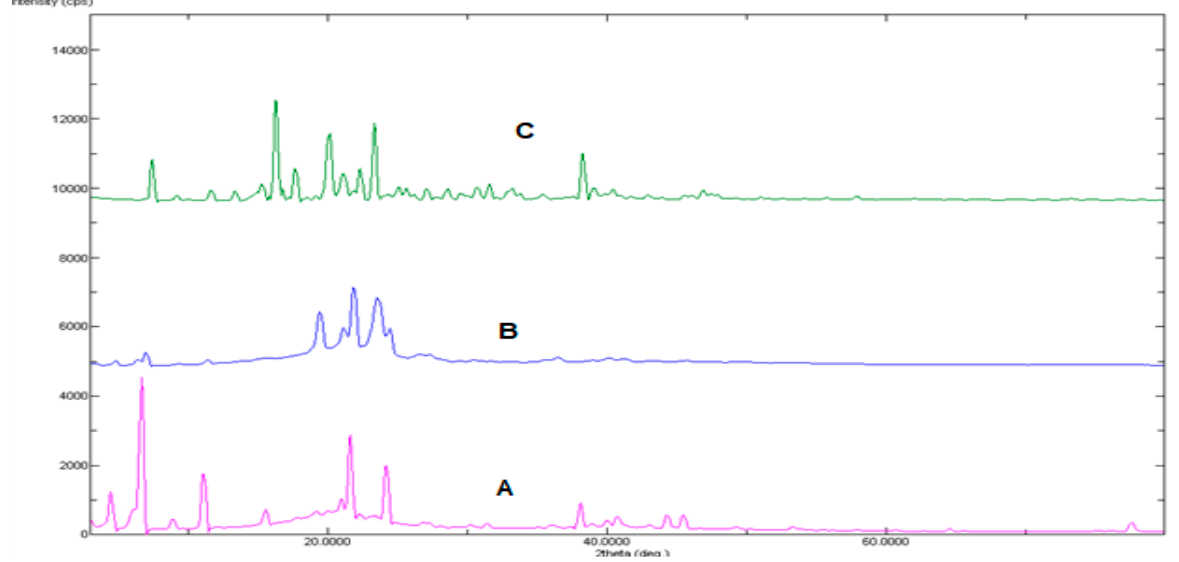
Figure 3. XRD of A: pure QTF, B: Lecithin, stearic acid, and Pluronic F-127 mixture, and C: the best formula.